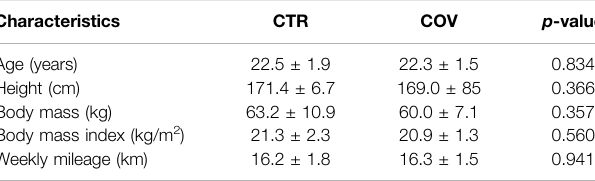
TABLE 1 | Participant characteristics according to group allocation (controls = CTR, COVID-19 = COV).